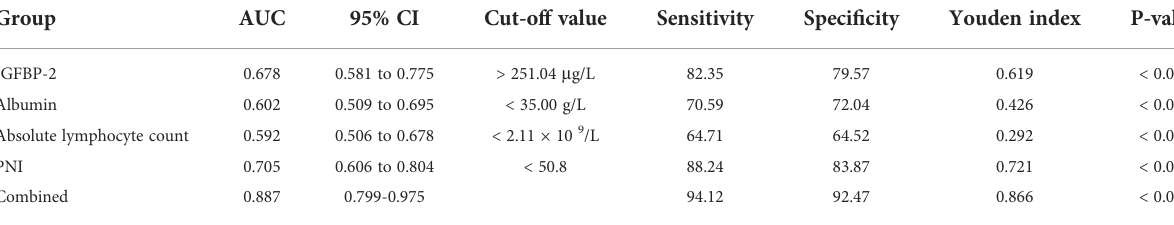
TABLE 6 IGFBP-2, Absolute albumin, lymphocytes, PNI in poor prognosis of esophageal cancer. Group AUC 95% CI